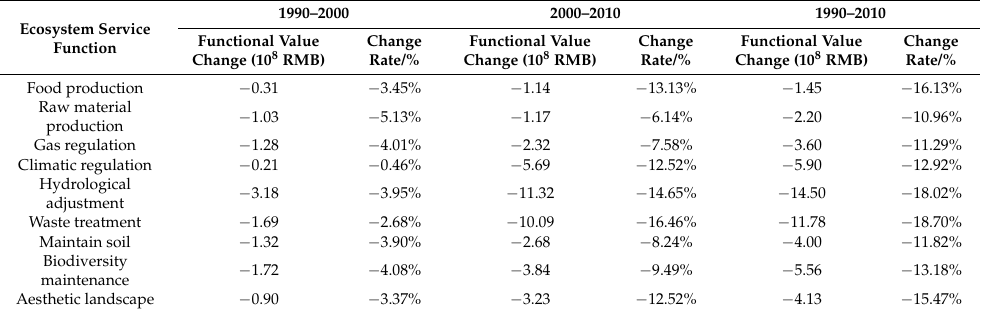
Ecosystem Service